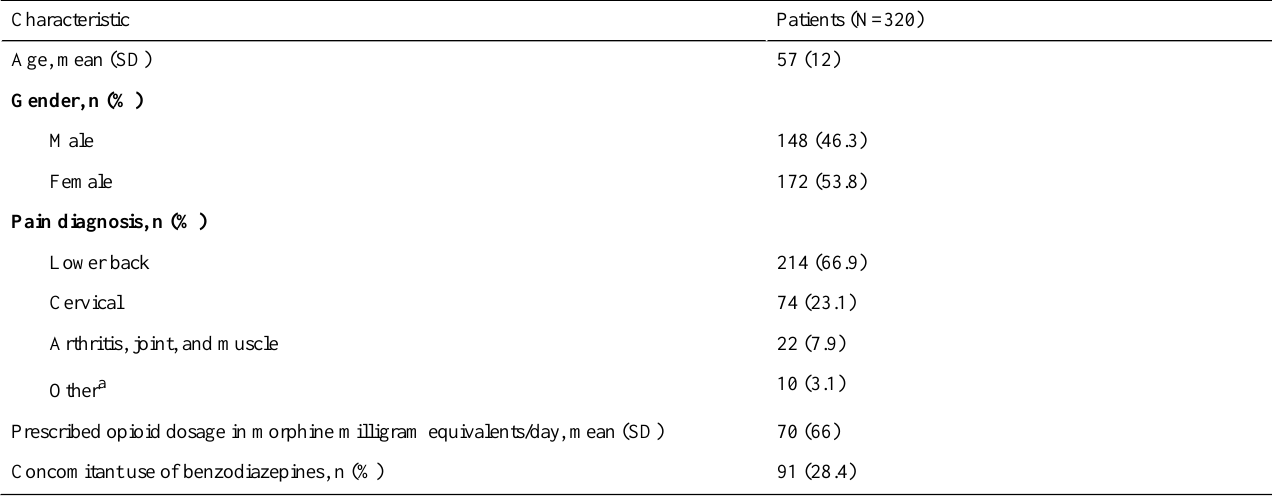
Table 1. Demographic and treatment characteristics of the patients included in the